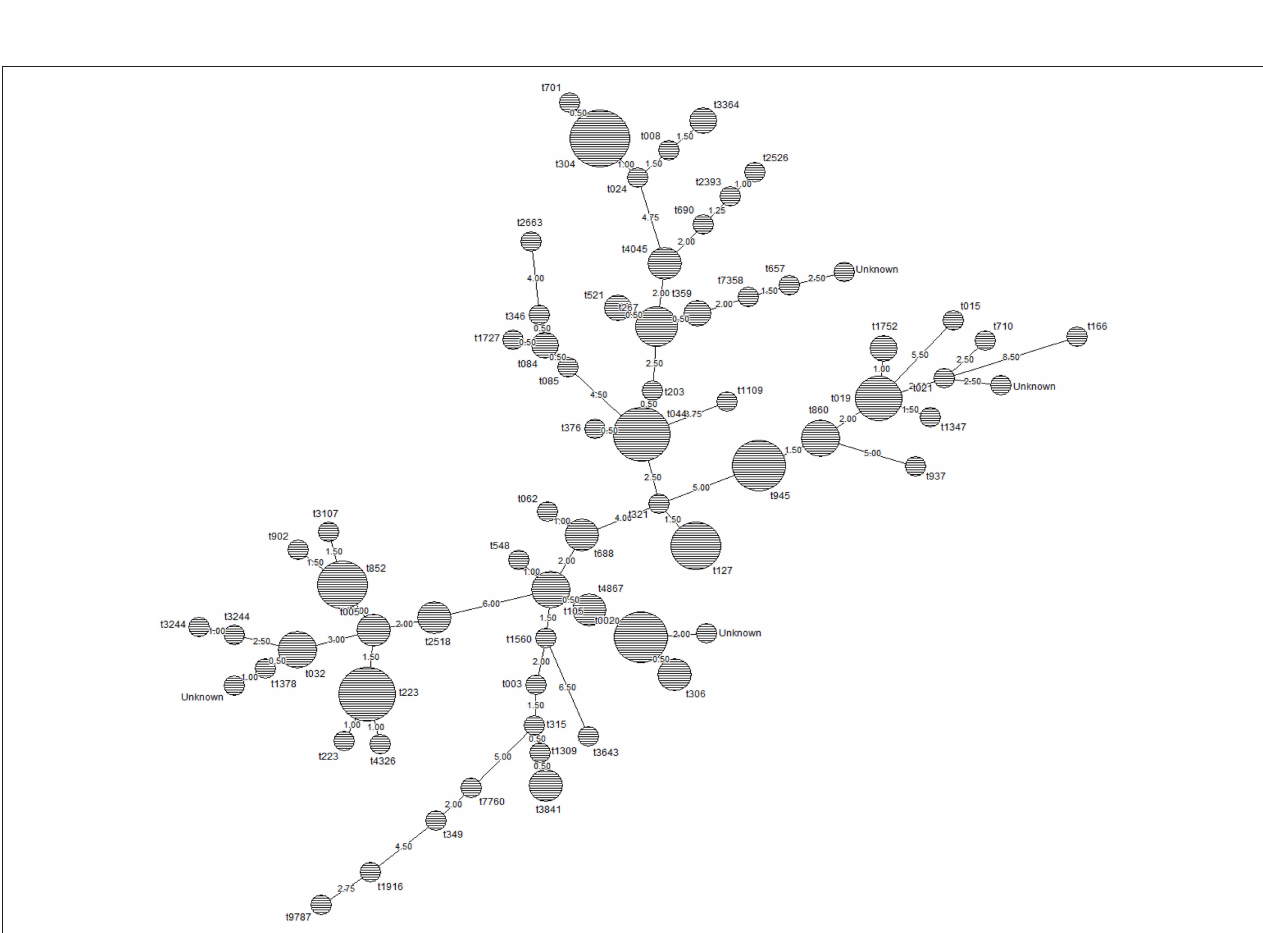
FIGURE 2 | Relationship between spa types of MSSA and MRSA isolates in this study. Node size is proportional to spa type frequency and line length is proportional to the number of mutational steps between the types. The node distances between the spa types was calculated by minimum spanning tree method using Dice correlation (BioNumerics v.7.1.). Based on the default setting of 1%, distance intervals are created that are converted into distance units. For example two entries when having a similarity of 99.6% will have a distance of 0 (interval 100–99% = distance 0). Two entries that have a similarity of 98.7% will have a distance of 1 (interval 99–98% = distance